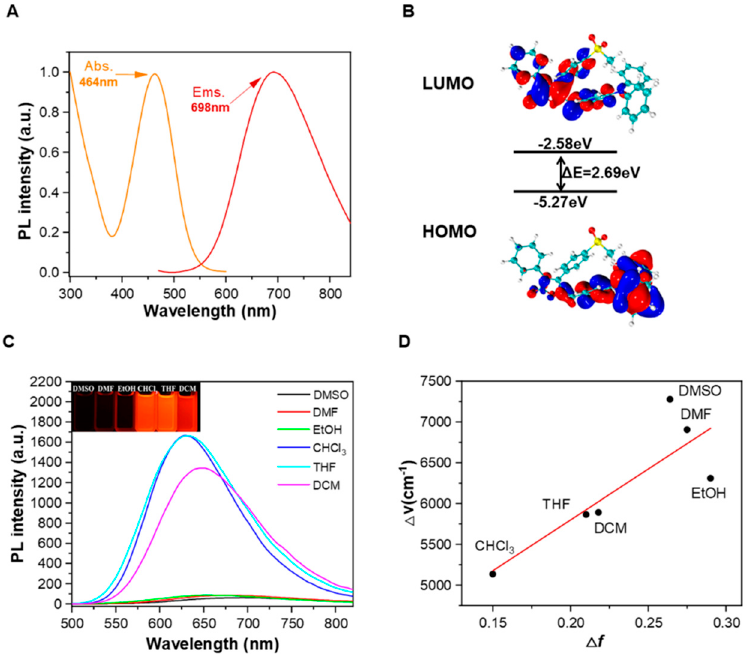
Figure 1. ( A ) Absorption and emission spectra of BY1 in DMSO (50 μ M). ( B ) HOMO/LUMO and its energy gap. ( C ) PL spectra of BY1 in various solvents (50 μ M), including DMSO, N , N -Dimethylformamide (DMF), ethyl alcohol (EtOH), CHCl 3 , tetrahydrofuran (THF), and Dichloromethane (DCM). ( D ) Δ v = ( ν A − ν F) = 1/ λ abs − 1/ λ em , ν A and ν F are the wavenumbers (cm − 1 ) of the absorption and emission. Δ f = orientation polarizability = ( ɛ − 1)/(2 ɛ + 1) ‒ (n 2 − 1)/(2 n 2 + 1), where ɛ = dielectric constant and n = refractive index).